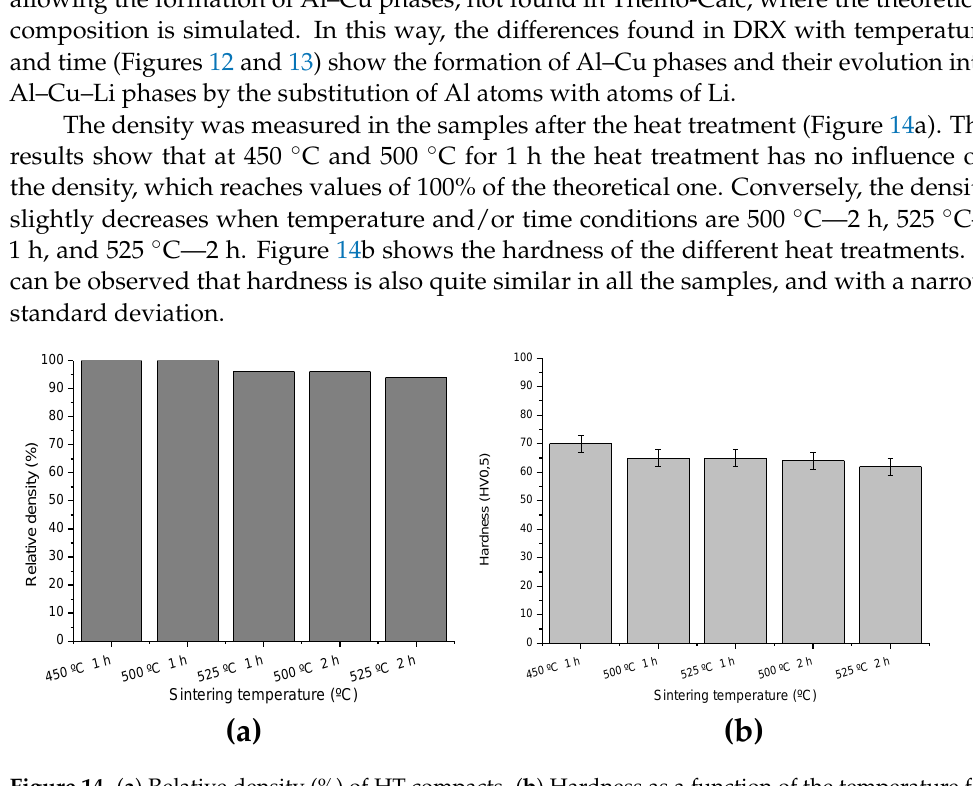
Figure 13. X-ray diffractograms of HT compacts at different temperatures and times.